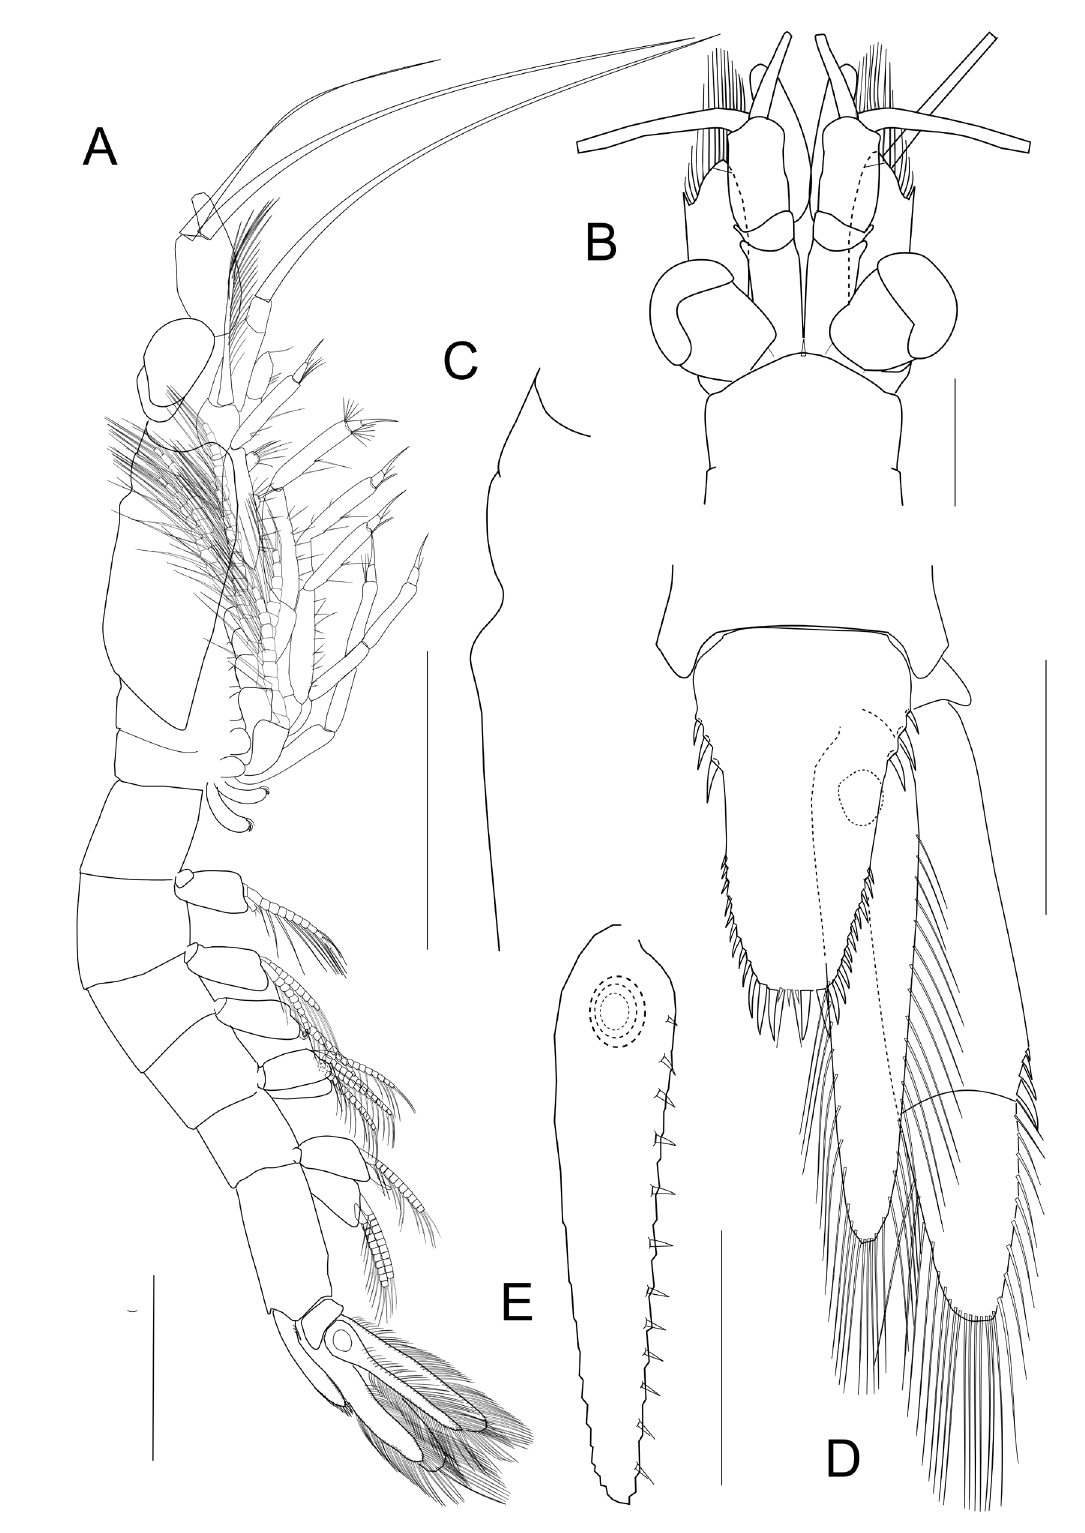
Fig. 14. Siriella muranoi sp. nov., holotype, ♂, length 5.5 mm, Port Essington, Arafura Sea, Northern Territory, Australia. A . Habitus. B . Anterior part of body. C . Anterior part of carapace, lateral view. D . Posterior part of body (left uropods not shown). E . Uropodal endopod, ventral view. Scale bars: A, C = 1 mm; B, D –E = 0.5